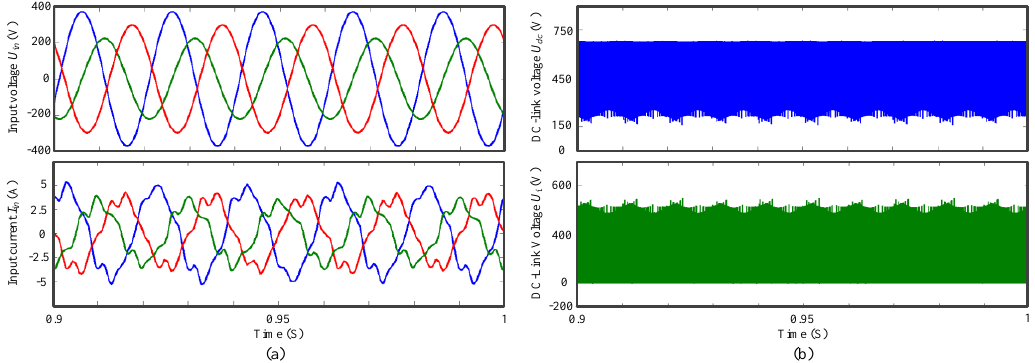
Figure 9. Input ( a ) abnormal-grid voltage and current; ( b ) abnormal supplied for DC-link voltage after and before